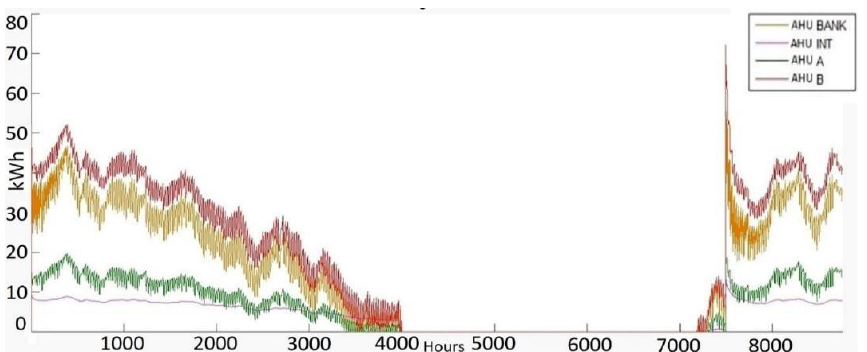
Figure 11. AHU hourly thermal energy consumptions.